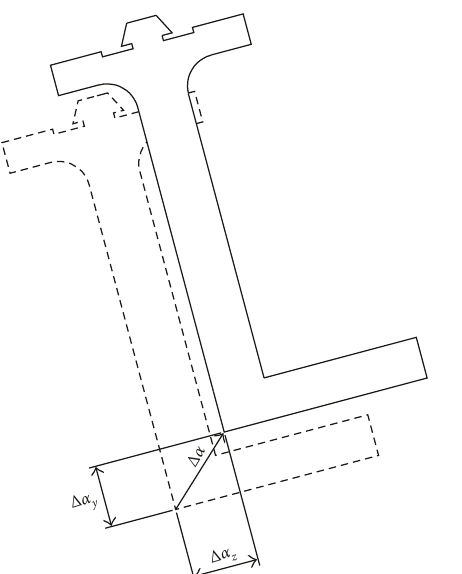
Figure 9: The front and back spatial positions of the end face contours.